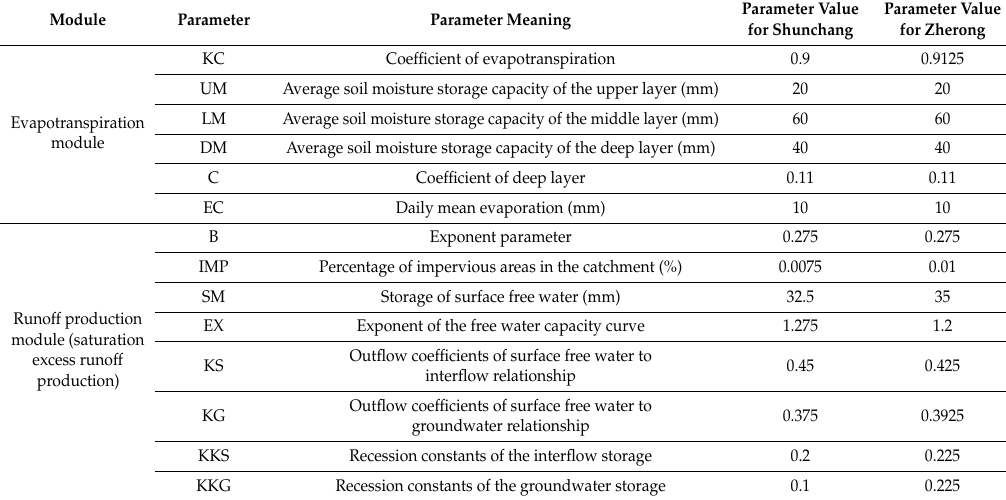
Table 6. Hydrological parameters used in the